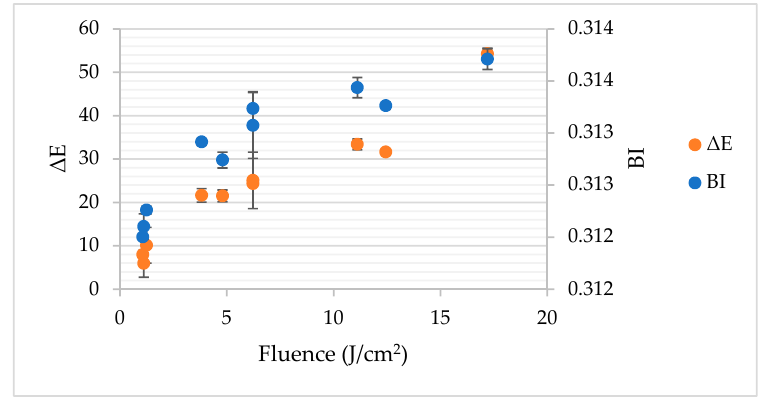
Figure 4. The impact of pulsed light on total colour difference ( Δ E) and browning index (BI) of gallic acid aqueous solution.